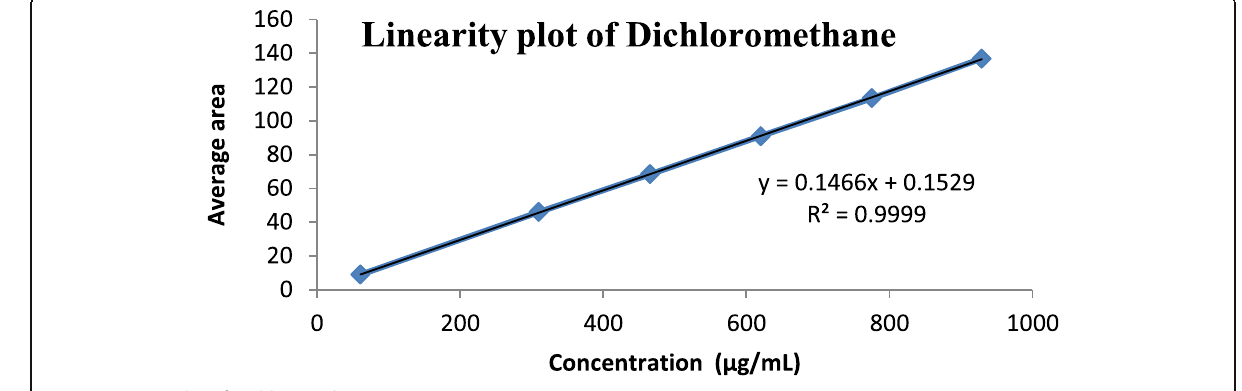
Fig. 8 Linearity plot of Dichloromethane